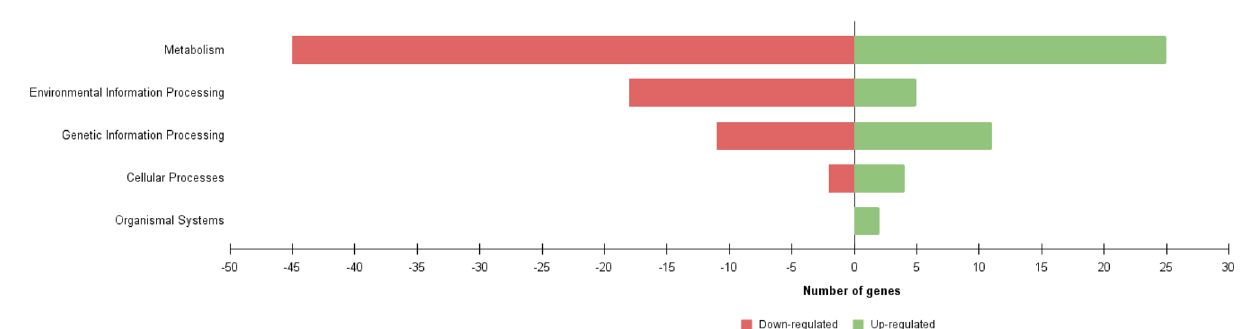
Figure 3. Number of up- and down-regulated genes of R . opacus R7 in response to polyethylene and malate according to KEGG identifiers. Distribution of the main KEGG classes including metabolism, environmental information processing, genetic information processing, cellular processes, and organismal